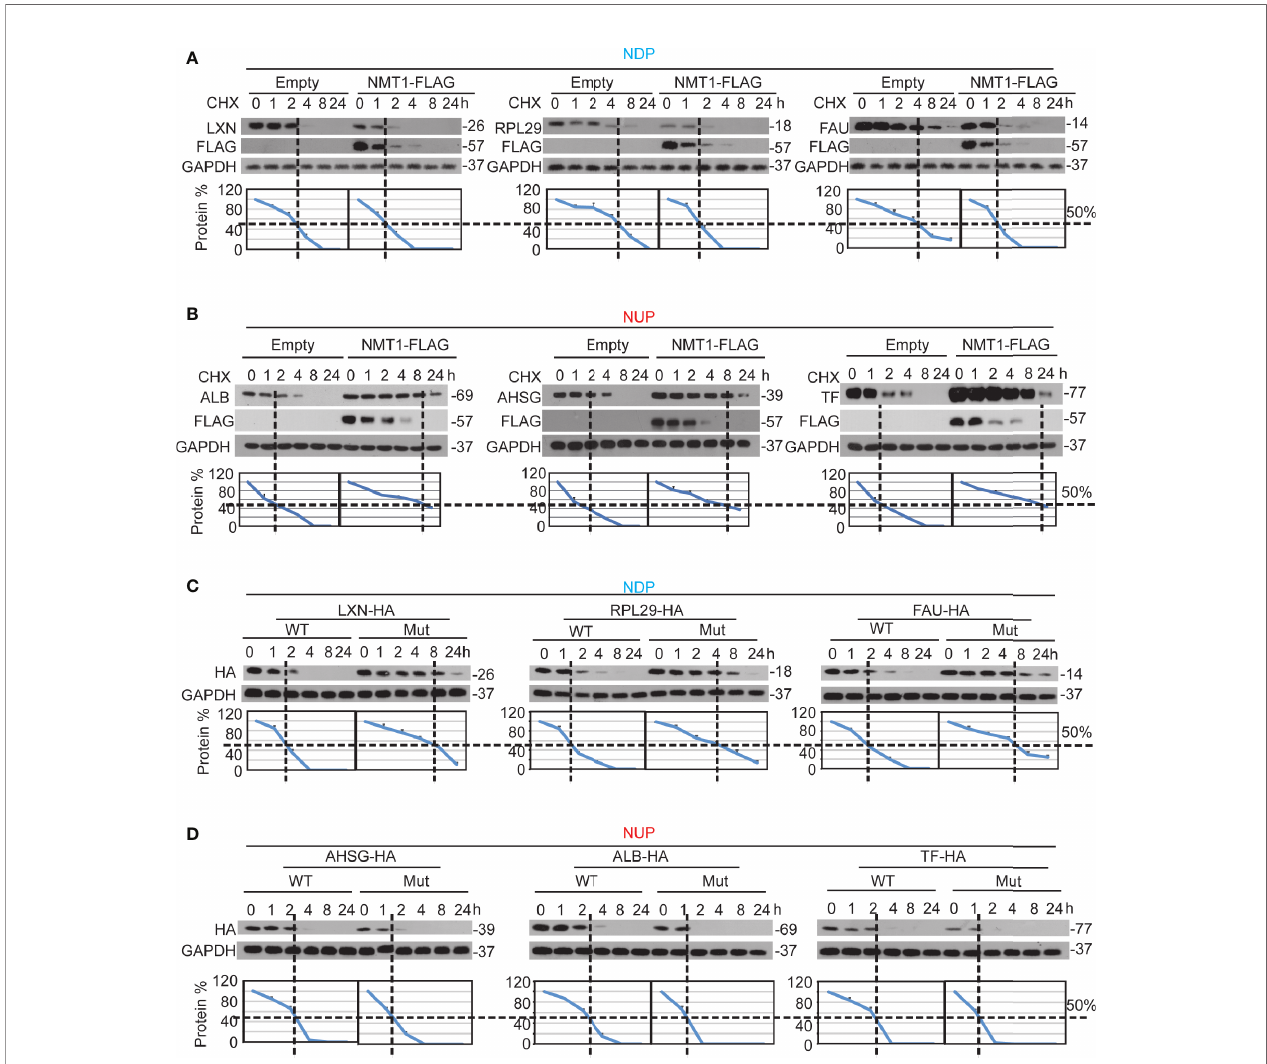
FIGURE 3 | NMT1 oppositely regulated half-life of NDP/NUP. (A, B) NMT1 shortened half-life of NDP while prolonged half-life of NUP. Protein was harvested in Bel- 7402 cells with or without NMT1 overexpression at indicated time after adding CHX ( fi nal concentration 0.1mg/ml). WB was then performed to evaluate half-life of NDP (A) and NUP (B) , respectively. (C, D) The NDP and NUP motifs were critical for the half-life of NDP and NUP. CHX chase experiments were performed in Bel- 7402 cells expressing exogenous NDP/NUP with (WT) or without (Mut) functional NDP/NUP motifs. The relative protein levels were graphed as the levels of NDP/ NUP to the levels of GAPDH from 3 independent experiments, and the relative levels of “ 0 h ” were arbitrarily set to 100%. Images of WB are representative ones of 3 independent